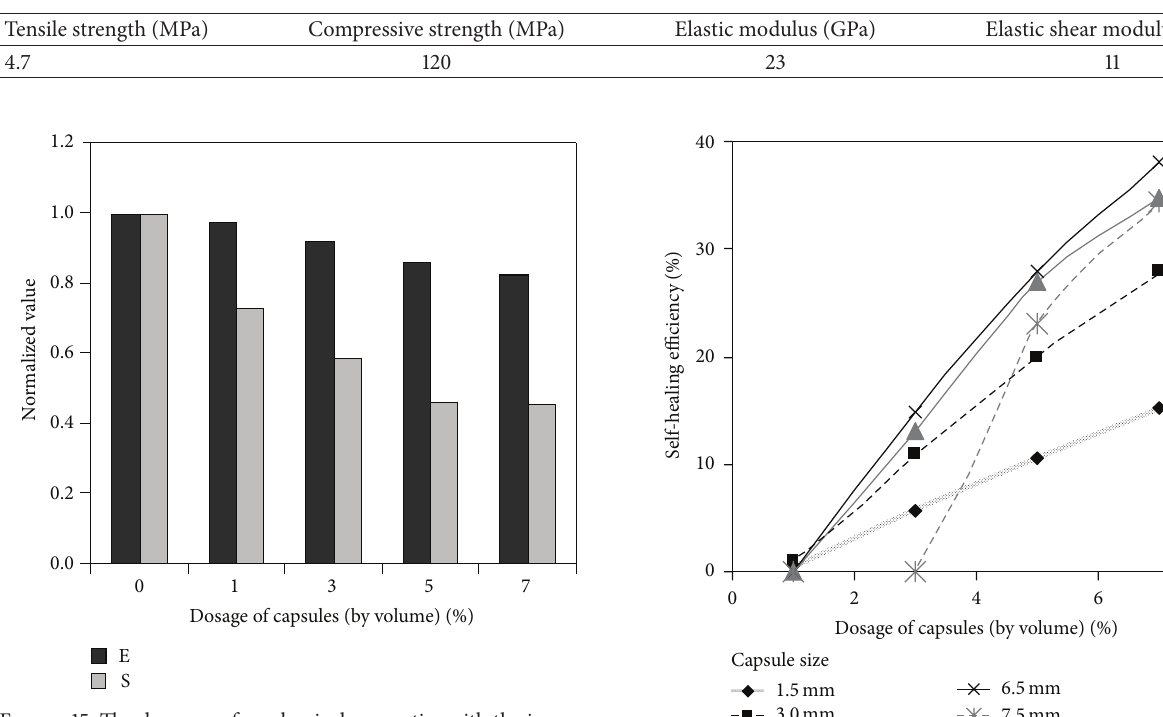
Table 1: Mechanical properties of cement paste [33].